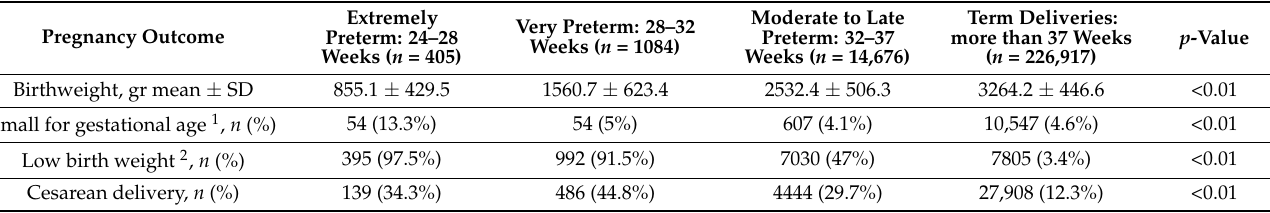
Table 2. Pregnancy outcomes for children (age < 18) by delivery